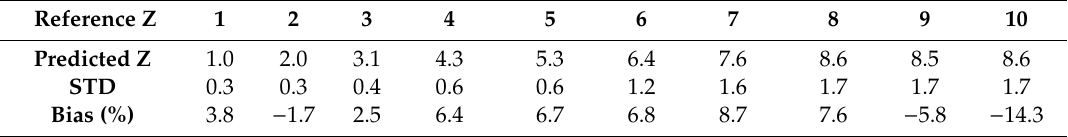
Table 3. Predicted Z by MLP for di ff erent depths of a monolithic detector module. The scintillation point was located at di ff erent Z positions as reference. At each depth, we estimated 10,000 scintillation Z positions.